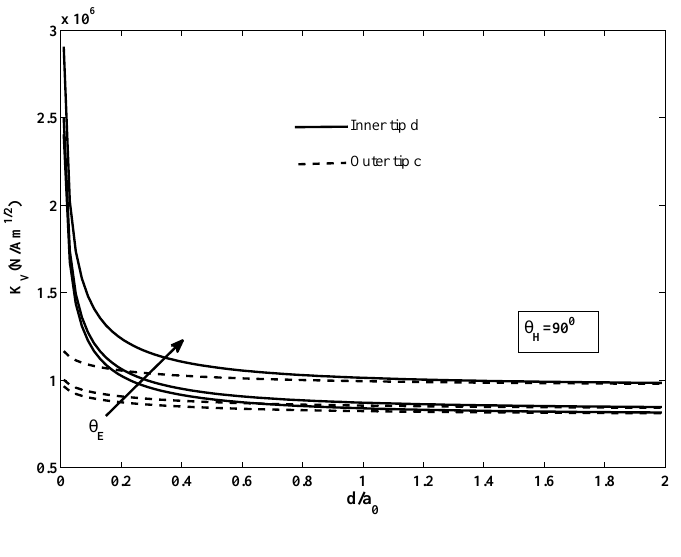
Fig. 10 MIIF versus inter-crack distance for different electric poling with fixed magnetic poling